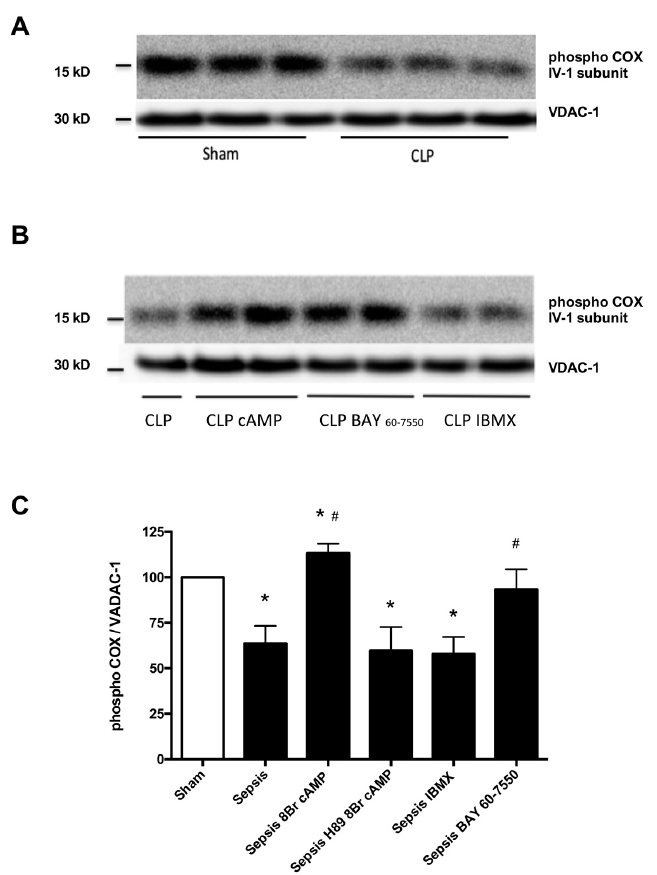
Figure 5. Representative Western blot images showing protein levels of Ser-58 phosphorylated cytochrome c oxidase (CcOX) subunit IV-1 of mitochondrial fractions isolated from three independent experiments in sham and sepsis (CLP) ( A ); representative Western blot images showing protein levels of Ser-58 phosphorylated cytochrome c oxidase (CcOX) subunit IV-1 ( B ); and densitometric quantification ( C ) of protein levels of Ser-58 phosphorylated cytochrome c oxidase (CcOX) subunit IV-1 normalized for VDAC-1 of mitochondrial fractions isolated from sepsis (CLP) mice after incubation with 8Br-cAMP alone and with H89 pre-exposure and after incubation IBMX; or BAY 60-7550. Results are expressed as percent changes from sham levels and displayed as mean ± SD. And analyzed with one-way ANOVA and Bonferroni’s multiple comparison post hoc adjustment ( n = 6 in each group; * indicates p < 0.05 versus sham; # indicates adjusted p < 0.008 versus Sepsis). In isolated septic hearts, myocardial efficiency (left ventricular developed force (LVDF) × heart rate/MVO 2 ) was markedly reduced as a result of larger decreases of LVDF compared with decreases